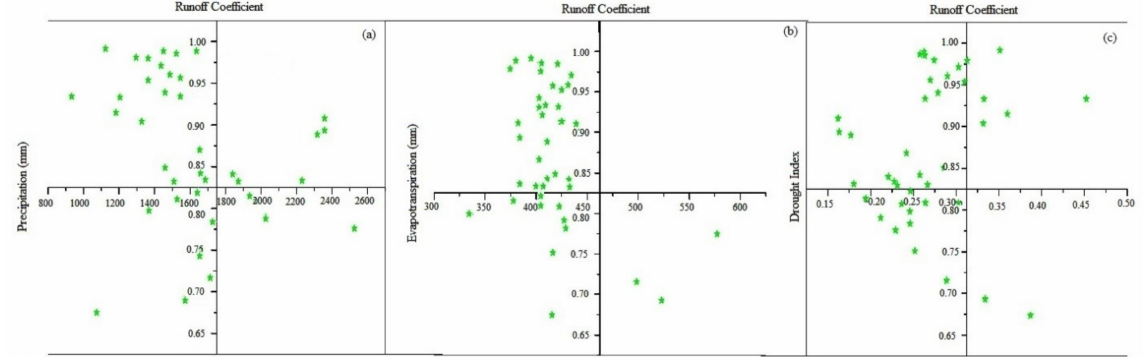
Figure 15. Scatter plots of ( a ) runoff coefficient vs. precipitation; ( b ) runoff coefficient vs. evapotranspiration; and ( c ) runoff coefficient vs. drought index.